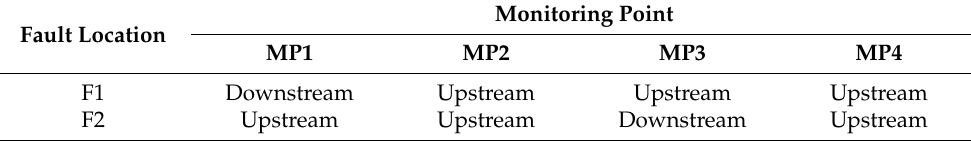
Table 5. Simulation results.